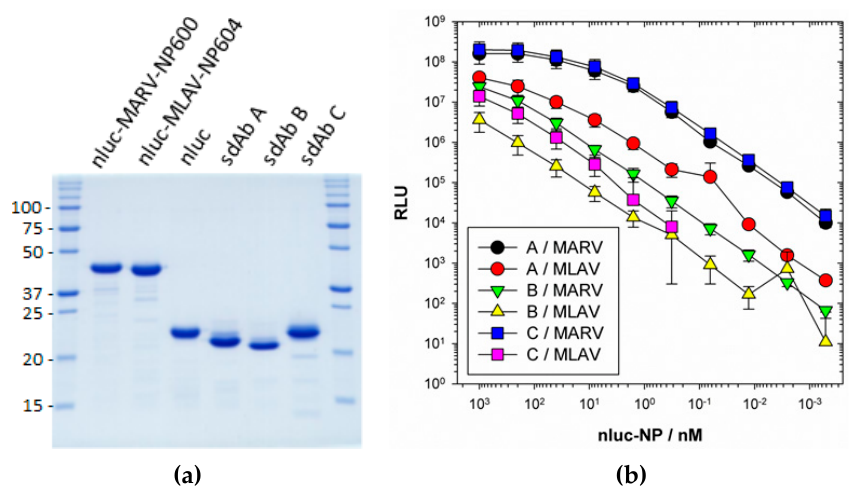
Figure 7. ( a ) Coomassie-stained 12% SDS-PAGE gel of 10 µg of the monovalent binding assay component proteins; sdAb, nluc and nluc–NP C-terminal domain. Molecular weights of markers are indicated to the left in kDa. ( b ) Titrations of fusions of nluc–NP C-terminal domains of either MARV or MLAV over oriented sdAb A, B or C with curves representing an n of 3 with error bars +/ − SD. EC 50 values +/ − SD calculated for MARV were; sdAb A, 21.5 +/ − 3.0 nM; sdAb B, 274.7 +/ − 39.5 nM; sdAb C, 21.0 +/ − 2.5 nM. These compare favorably with our previous determinations using this assay format; sdAb A, 24.7 +/ − 6.1 nM; sdAb B, 131.6 +/ − 33.1 nM; sdAb C, 32.0 +/ − 1.0 nM [18].